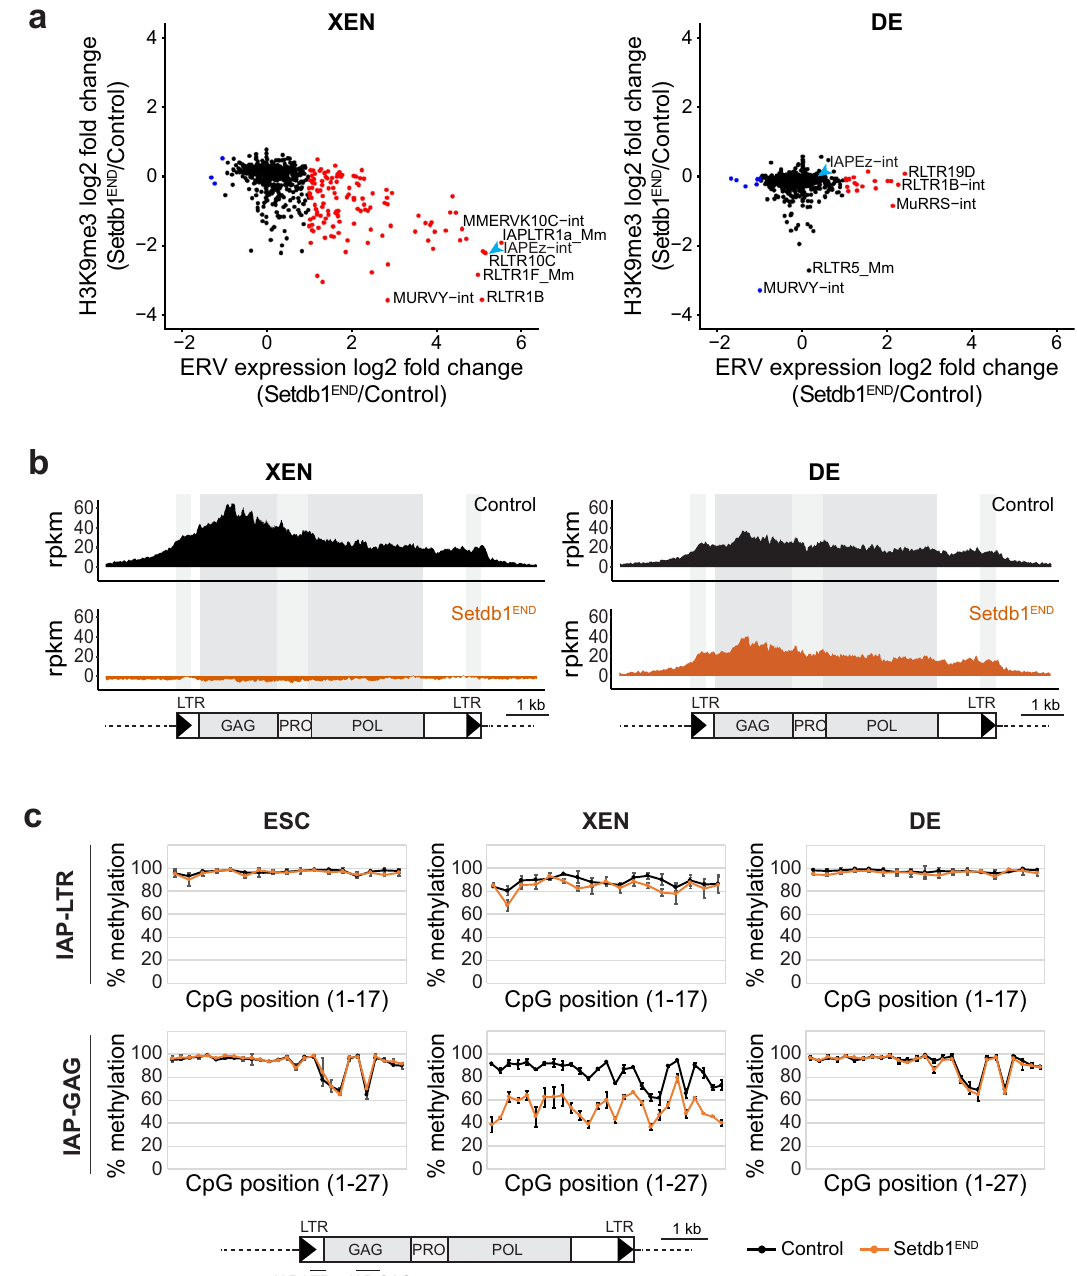
Fig.4|Setdb1iscriticaltomaintainH3K9me3andDNAmethylationonERVsin XEN,butnotDEcells.a Dotplotshowingexpressionvs.H3K9me3changesonERV families between control and Setdb1 END XEN and DE cells. ERV families with sig- ni fi cantly changed expression (fold change > 2; n =3 for each condition) are colored (red = increased expression in Setdb1 END cells). Selected ERV families are labeled. b Cumulative H3K9me3 ChIP-seq coverage across IAP elements in control and Setdb1 END XEN and DE cells. The structure of IAP elements is shown